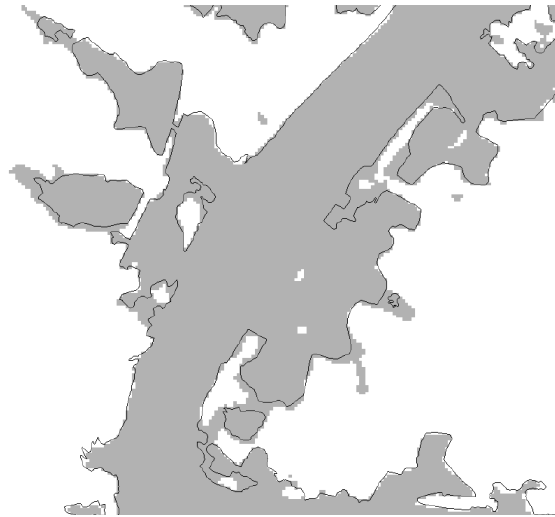
Figure 7. The derived flood inundation area with digitised flood lines overlaid